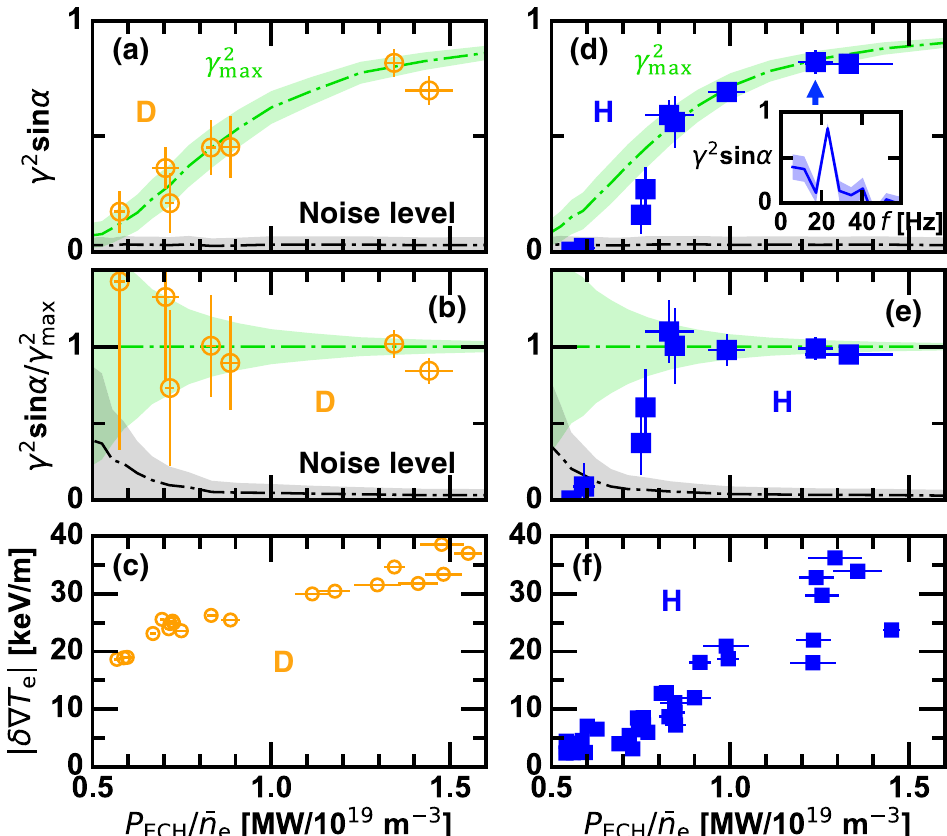
Figure 7. ( a , d ) Squared coherence of the HIBP difference current with respect to the ECH modulation pulse, ( b , e ) that normalized by its maximum possible value, and ( c , f ) the peak-to-peak modulation amplitude of the electron temperature gradient as a function of the applied ECH power normalized by the line averaged density for deuterium plasmas and hydrogen plasmas, respectively; and (insert) squared coherence spectrum for a low density hydrogen